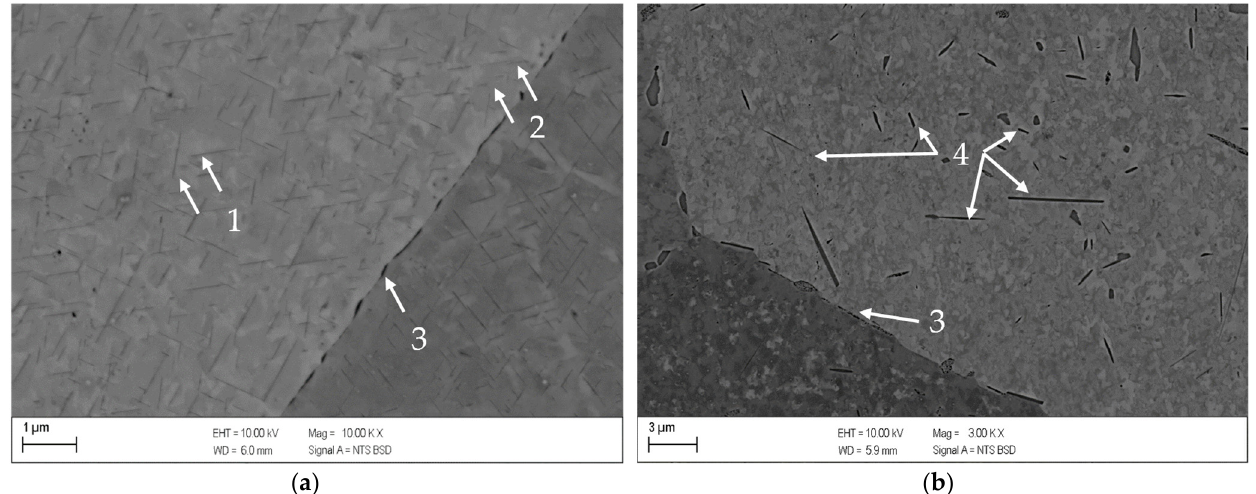
Figure 8. Precipitates of CuSc0.3 in their evolution during DSC measurements: specimen without cold rolling; ( a ) condition 1; ( b ) condition 2; showing homogenously distributed lamellar scandium enrichments of precipitates within a grain (1), fewer and smaller structures in the surroundings of the grain boundary (2) with scandium migration in the intergranular space (3) and coarsening precipitates due to further heating (4).